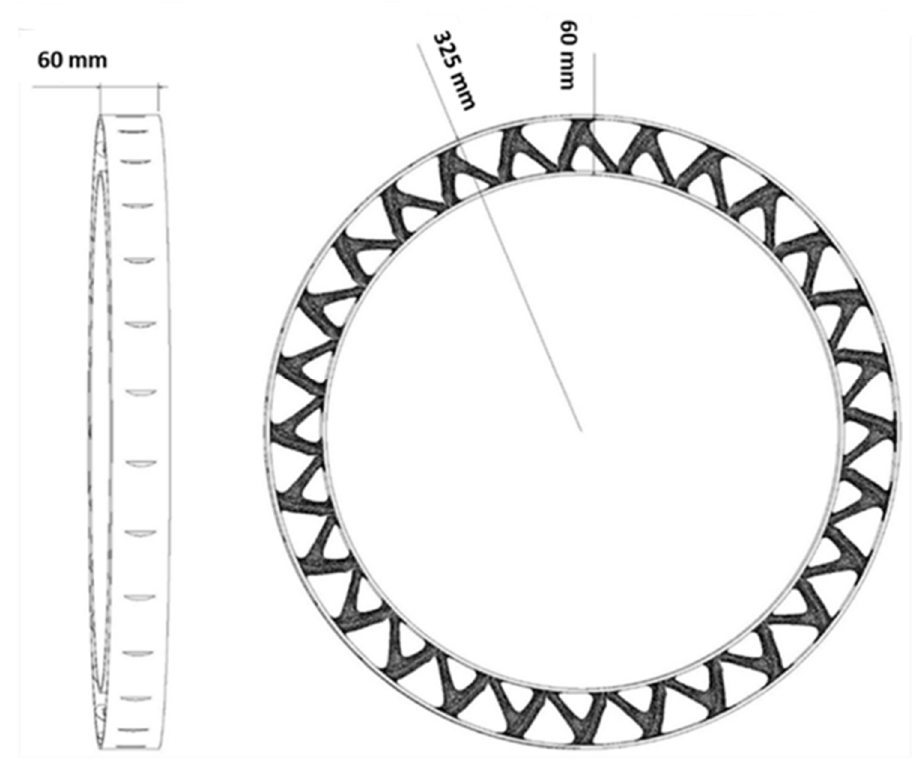
Figure 21. Arrangements of cells in the non-pneumatic tire.